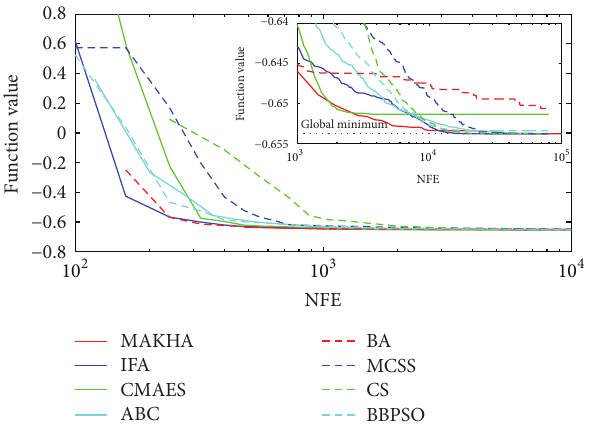
Figure 9: The evolution of the mean best value calculated via the eight metaheuristics versus NFE for problem RG7.